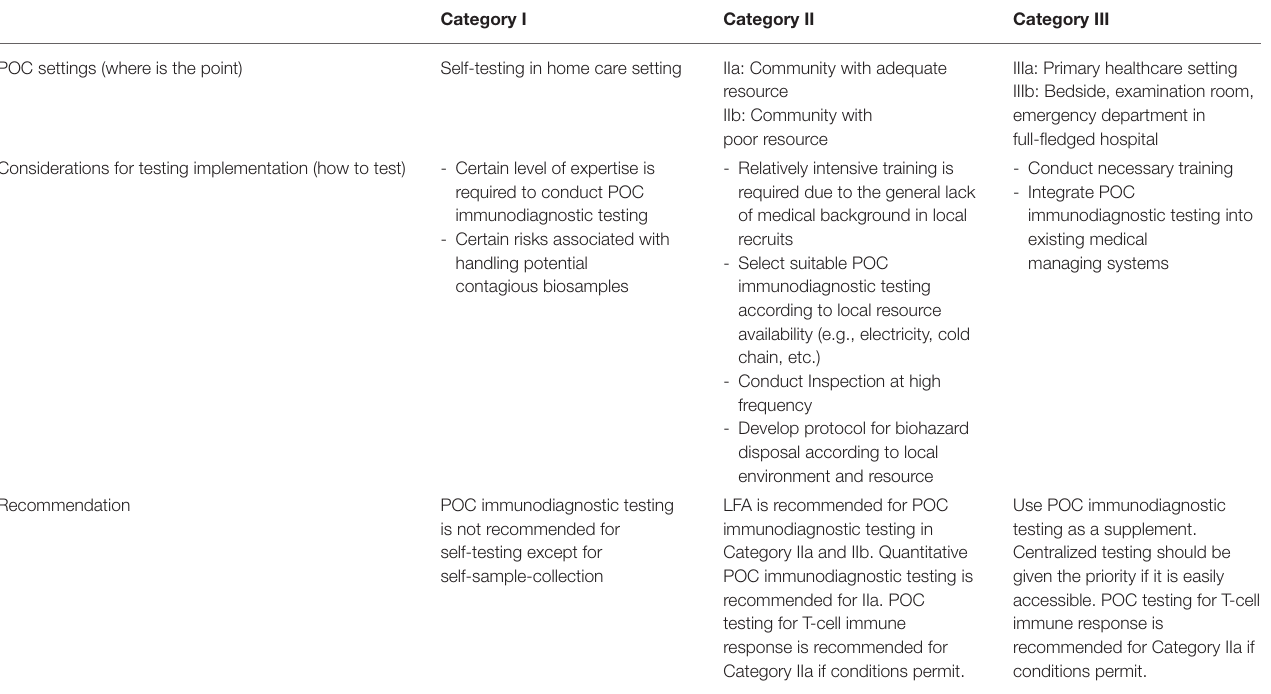
TABLE 1 | Settings and applicable scenarios for POC immunodiagnostic